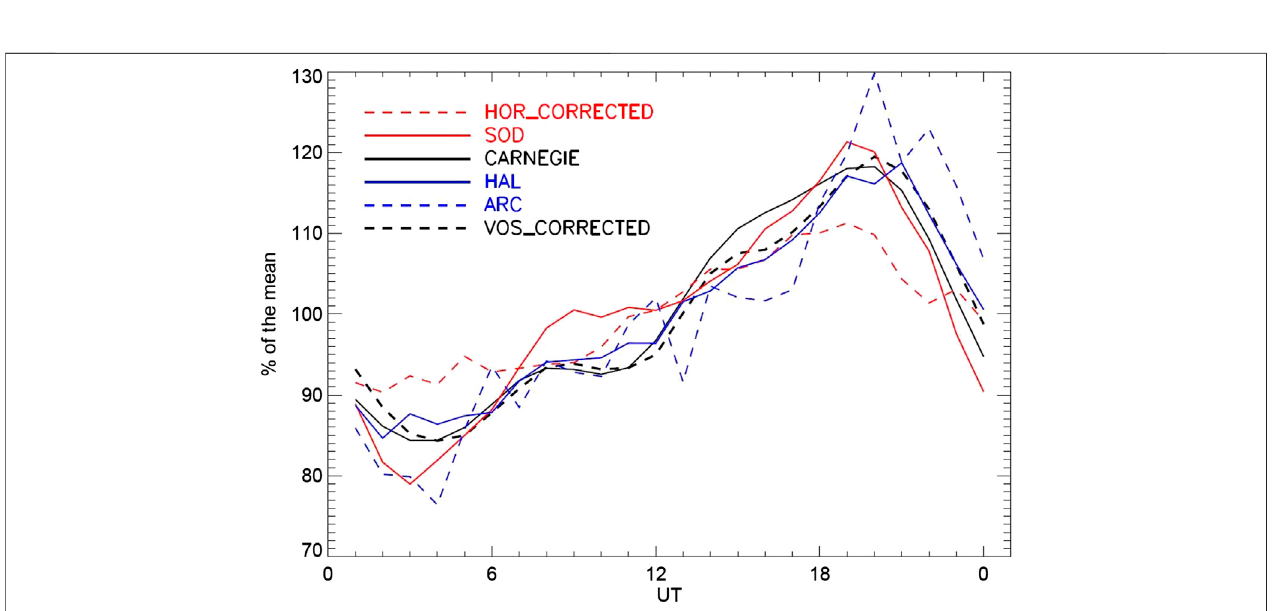
FIGURE 10 | Comparison of the PG annual daily variation, in fair weather conditions, between Sodankyla, SOD (red solid line), Hornsund, HOR (red dashed line), Halley,HAL(bluesolidline),Arctowski,ARC(bluedashed line),Vostok,VOS (black dashed line)andtheCarnegiecurve,plottedaspercent ofthemean.Thein fl uenceof the cross polar cap potential has been removed for Vostok and Hornsund stations in accordance with the methodology in Ionospheric Potential Contributions .